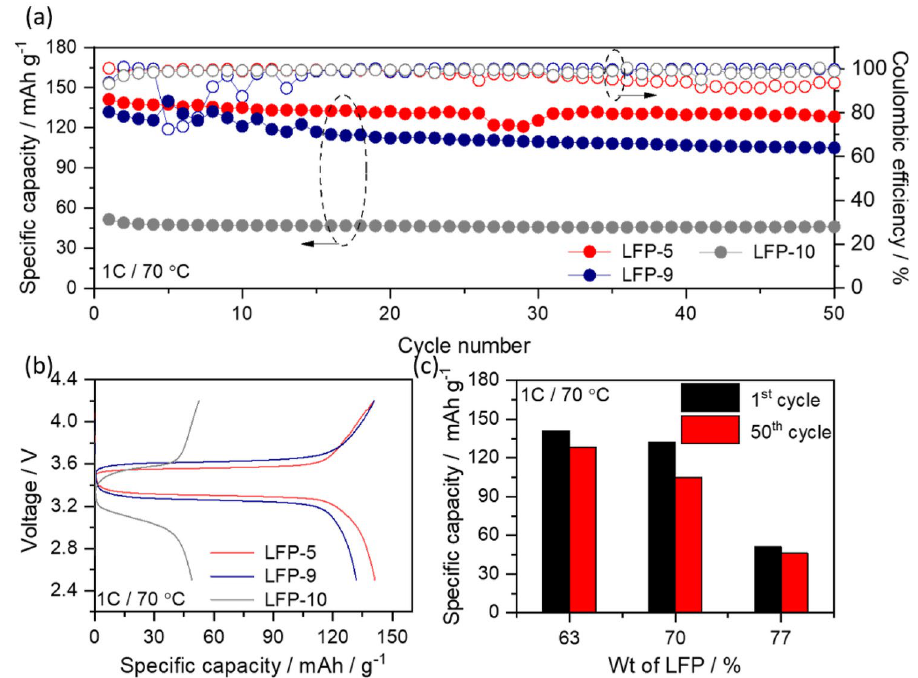
Figure 7. ( a ) Cycle performance curves of Li/SPNE/LFP cells using LFP-5, LFP-9 and LFP-10 cathodes measured at 1C rate at 70 °C, ( b ) the corresponding first charge/discharge curves, and ( c ) comparative specific capacity vs different weight ratios of LFP content in the